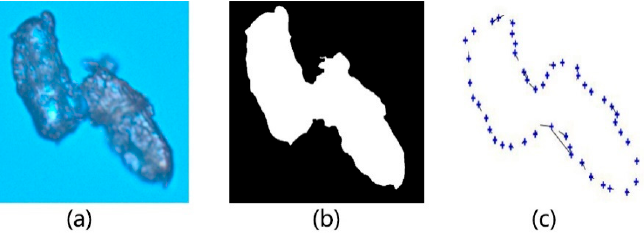
Figure 5. Extraction of Feature points: ( a ) Original image; ( b ) Binary image; ( c ) Feature point.